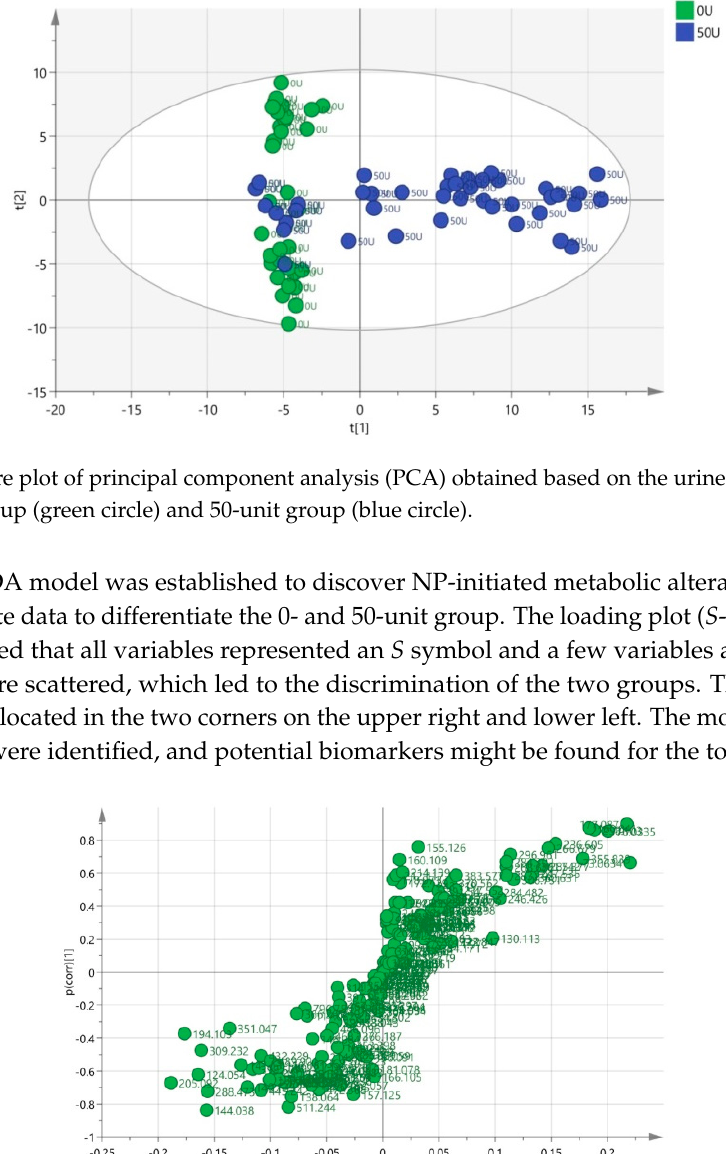
Figure 7. The loading plot ( S -plot) of OPLS-DA for the 0 unit vs. 50 units.